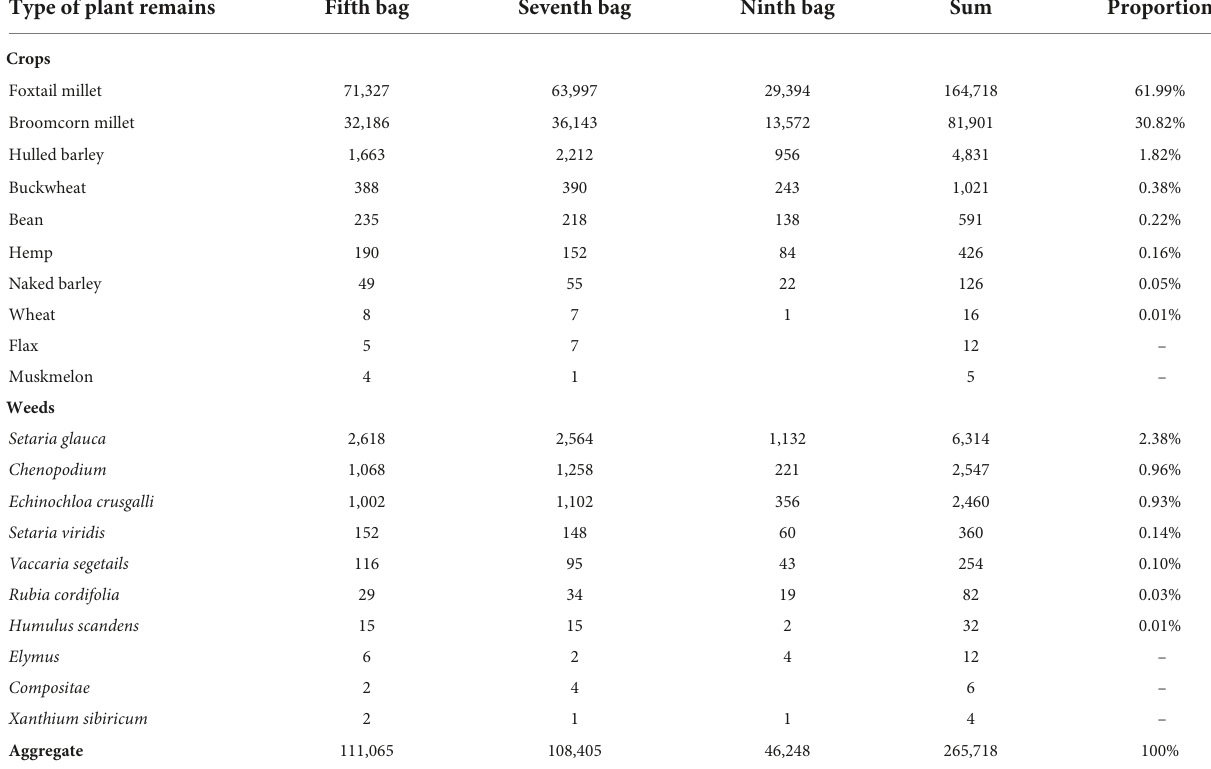
TABLE 1 Summary data for the identified plant remains from the Chashancun